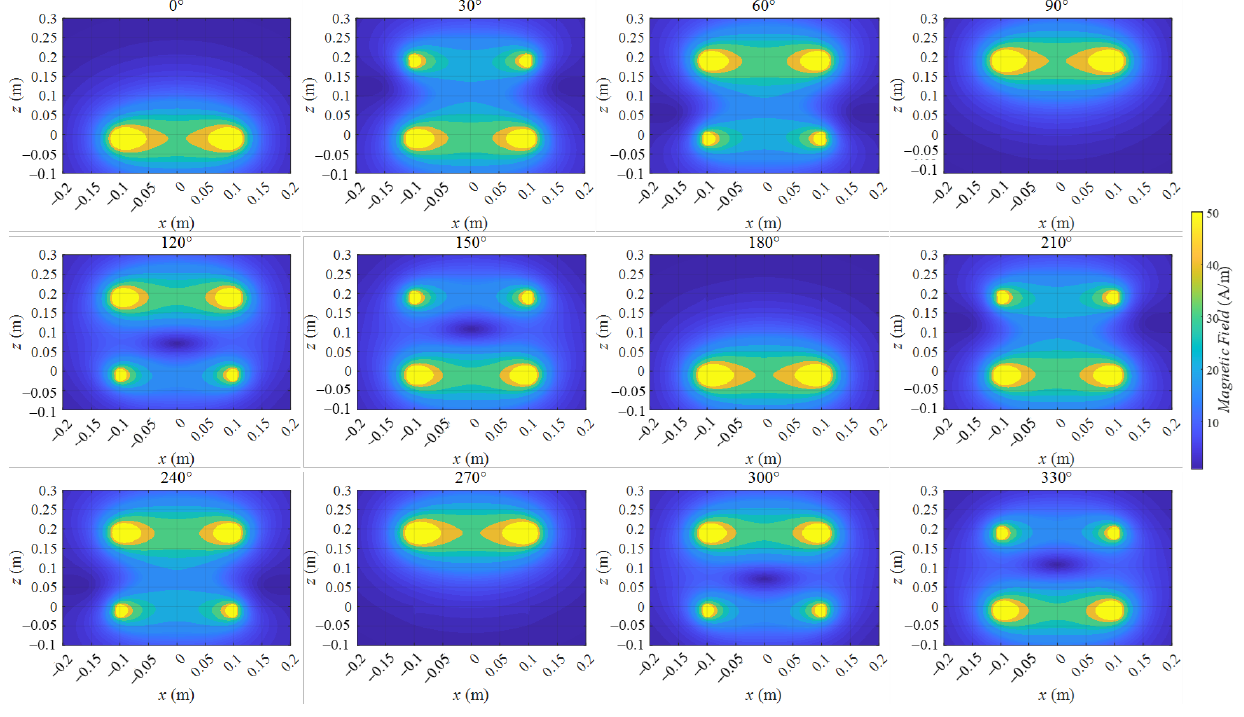
Figure 2. Magnetic field distribution on the xoz plane varying with time phases from 0° to 330° in 30° increments. Figure 2presents a whole cycle period from 0° to 330°. The degree symbol stands for the time in one period.